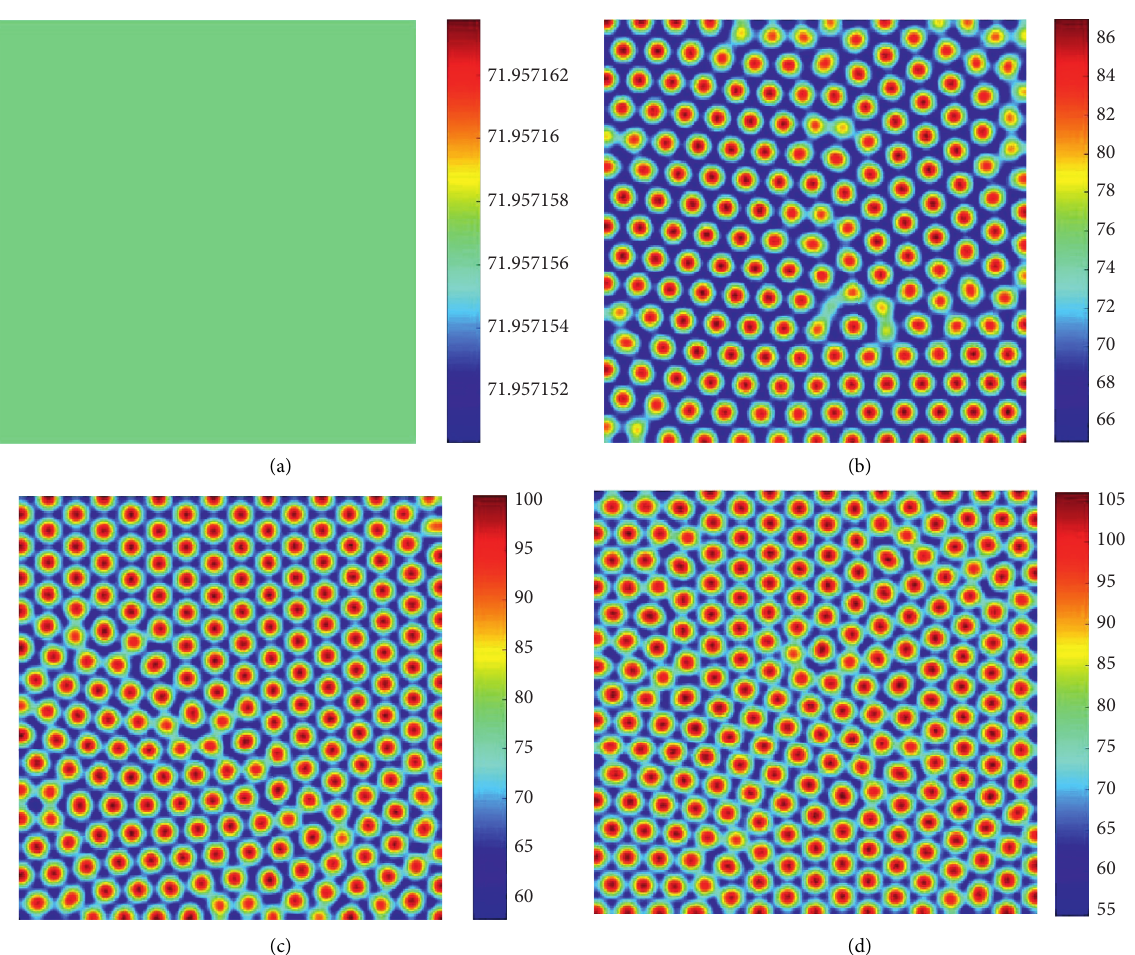
Figure 4: The spatial patterns of the predator with different value of 31: (a) 31 � 1.025; (b) 31 � 1.009; (c) 31 � 0.9; (d) 31 �